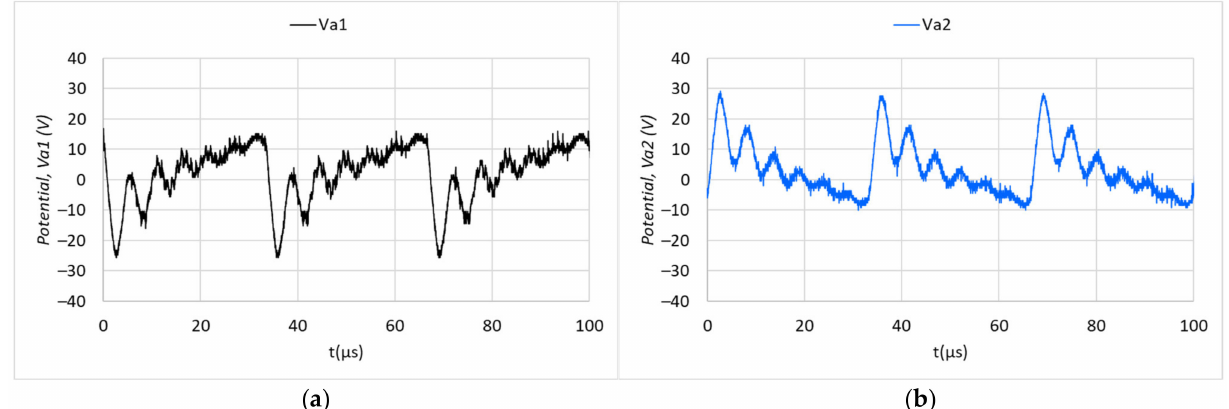
Figure 10. ( a ) The complementary modified sawtooth waveforms at the connection points of the receiver coil and the multilayer actuators. Period of the motor operating frequency is 33 µ s (30 kHz). ( a ) at point Va1, ( b ) at point Va2 (see Figure